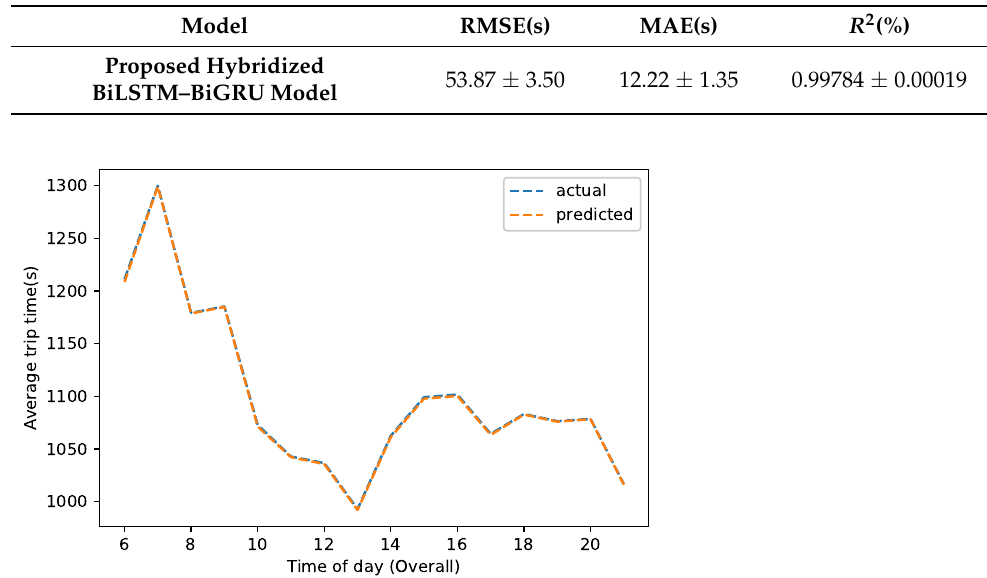
Figure 9. The actual vs. predicted normalized travel time using our proposed heterogeneous BiLSTM– BiGRU-based ensemble